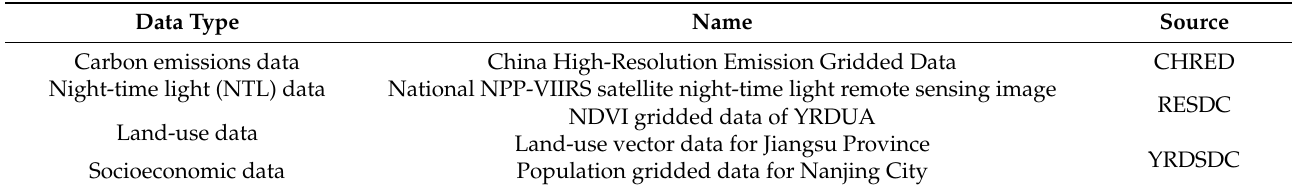
Table 1. Data and their sources employed in this